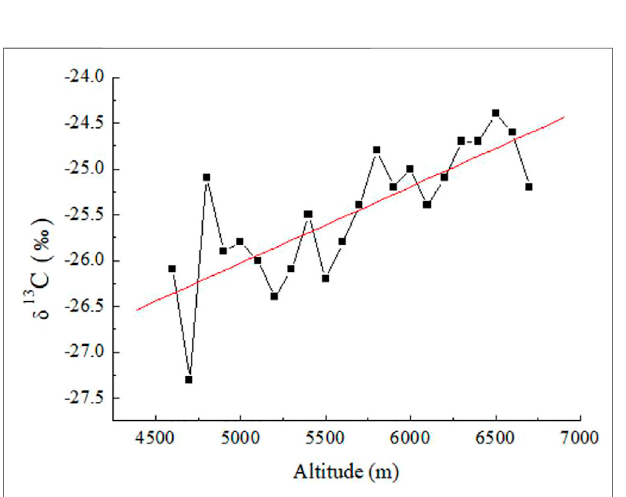
FIGURE 6 | Altitudinal variations of ACL 27 – 31 . ACL 27 – 31 is calculated from weighted-mean chain length of C 25 , C 27 , C 29 , C 31 and C 33 n